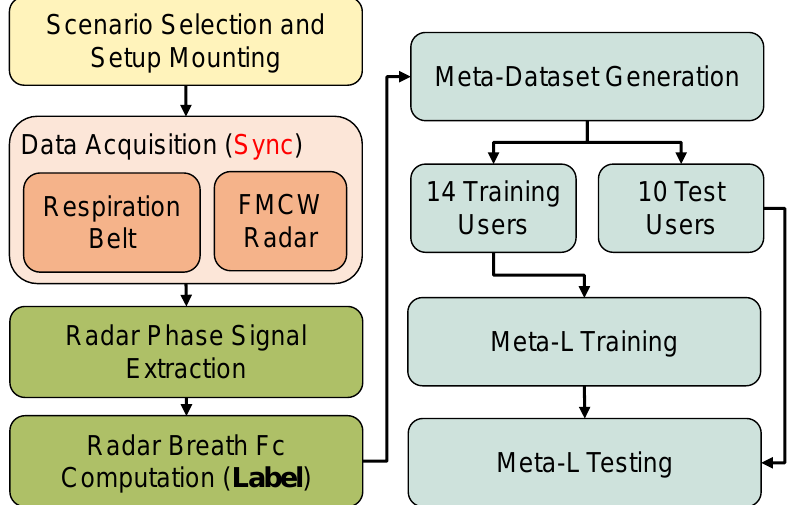
Figure 2. The diagram shows the main steps of the implementation. For a chosen scenario (room and user), several data sessions with synchronized radar and a reference respiration belt are collected.